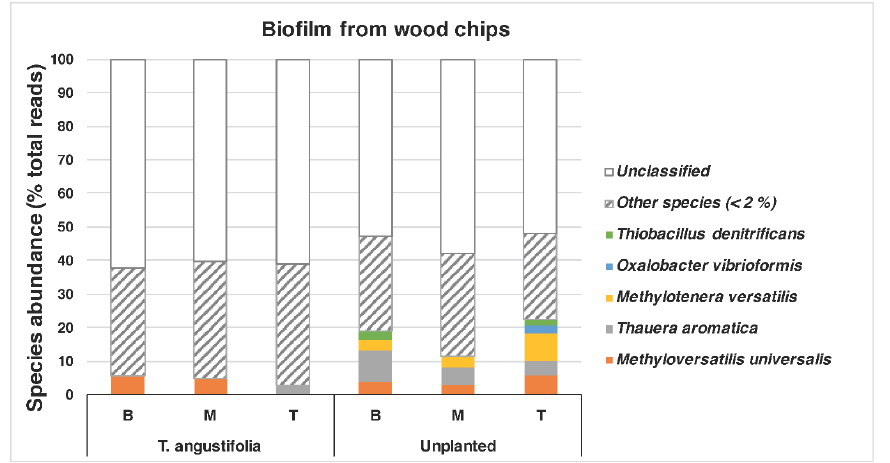
Figure 6. Relative bacterial composition at the species level in the T. angustifolia and unplanted reactors’ media. ”Other species” is the sum ratios of species with less than 2% abundance. B, M and T represent the bottom (60 cm), middle (40 cm) and top (20 cm) depths, respectively.